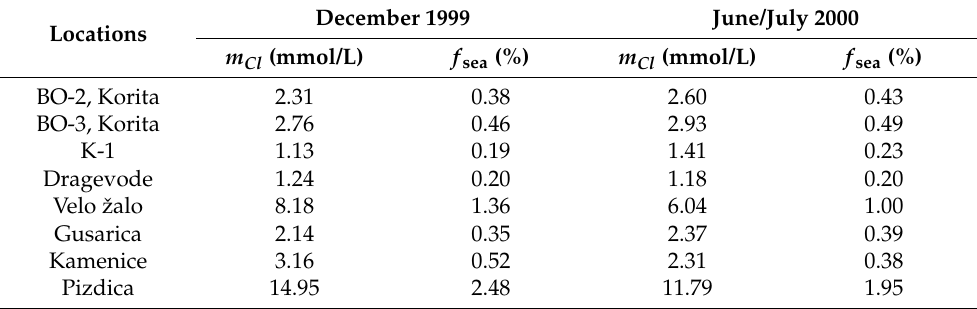
Table 4. Seawater percentage in spring and groundwater samples from Vis